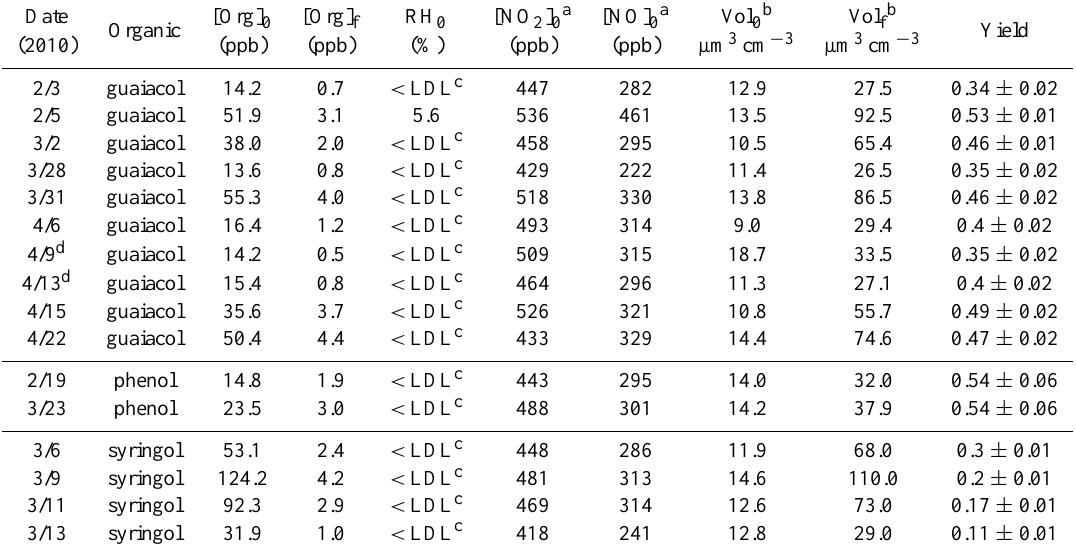
Table A1. Experimental conditions and aerosol yields in the presence of added NO x